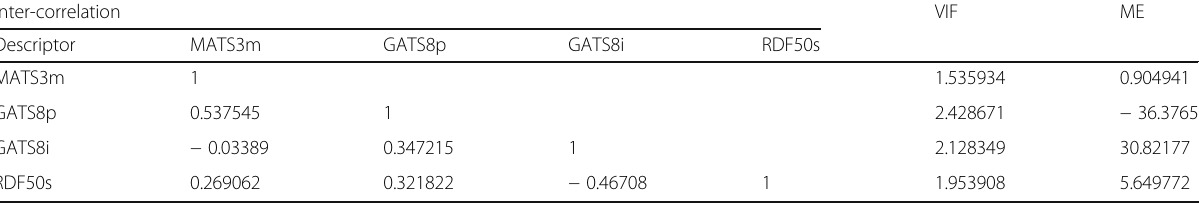
Inter-correlation